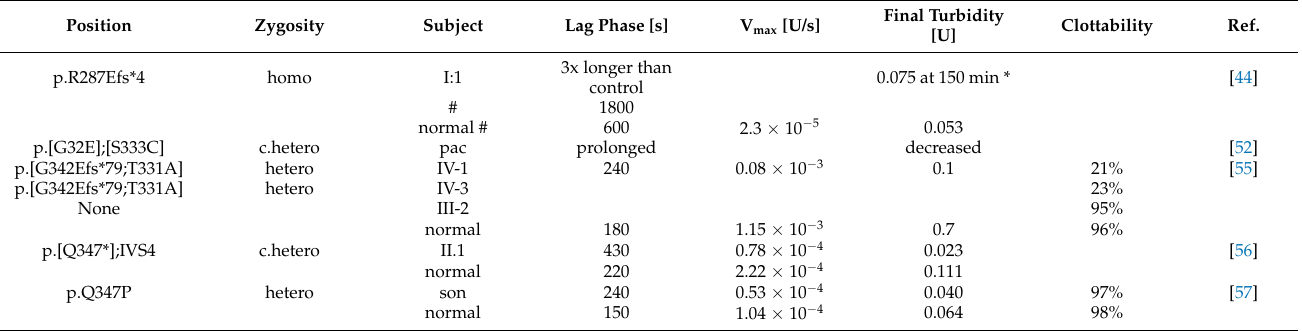
Table 4. Polymerization characteristics of fibrinogen with mutations in the α C-connector of fibrinogen. Values designated by # were read out of the graph in the original report. * = fibrin still polymerizes; c.hetero = compound heterozygote; homo = homozygote; hetero = heterozygote; IVS4 = intronic mutation